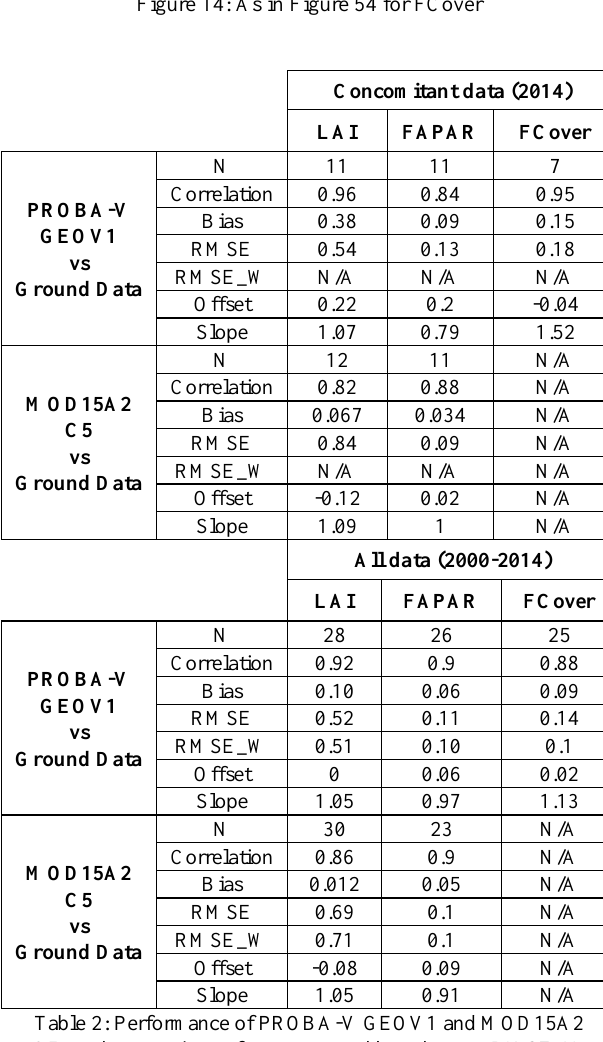
Table 2: Performance of PROBA-V GEOV1 and MOD15A2 C5 products against reference ground based maps. RMSE_W stands for weighted